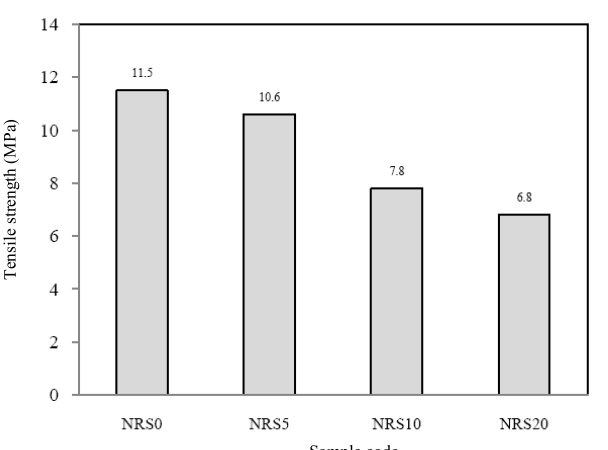
Figure 5. Tensile strength of samples at various silica